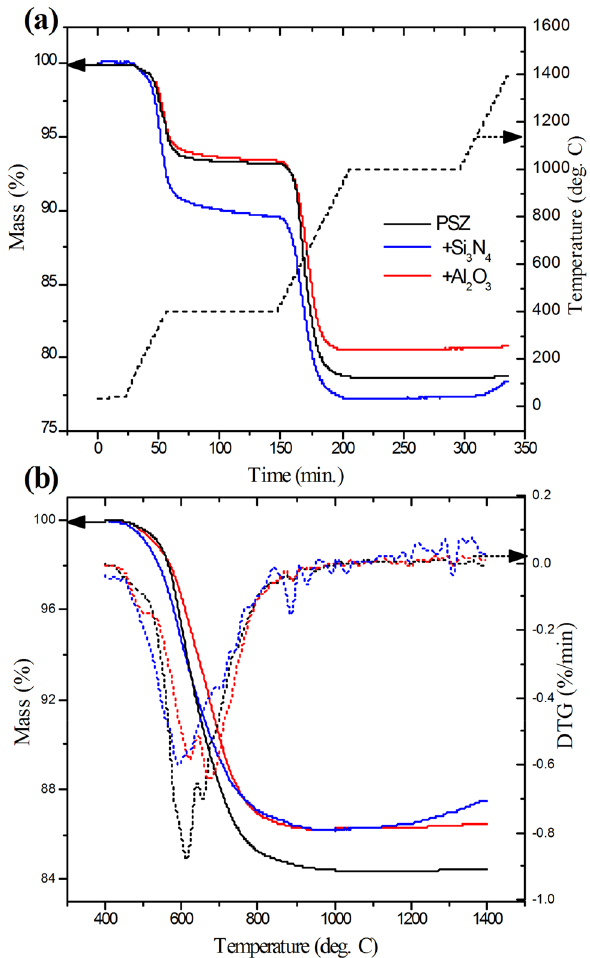
Figure 7. Thermogravimetric analysis under argon. ( a ) The mass loss as a function of time during curing and pyrolysis steps (black dash line indicates the temperature profile) and ( b ) The mass loss during the pyrolysis step only (T > 400 °C) along with the derivative signal (DTG, dotted lines). The DTG signal was smoothed (origin 8 software, FFT filter set at 5